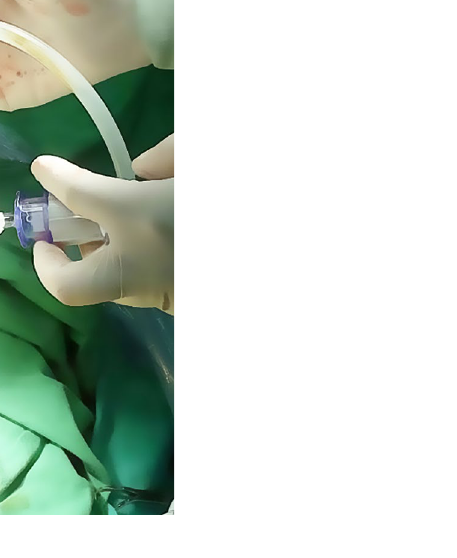
Figure 1. Single port laparoscopic